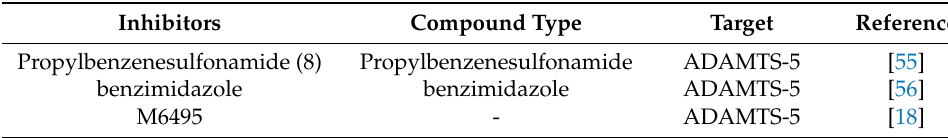
Table 2. Small molecule inhibitors targeting ADAMTS for